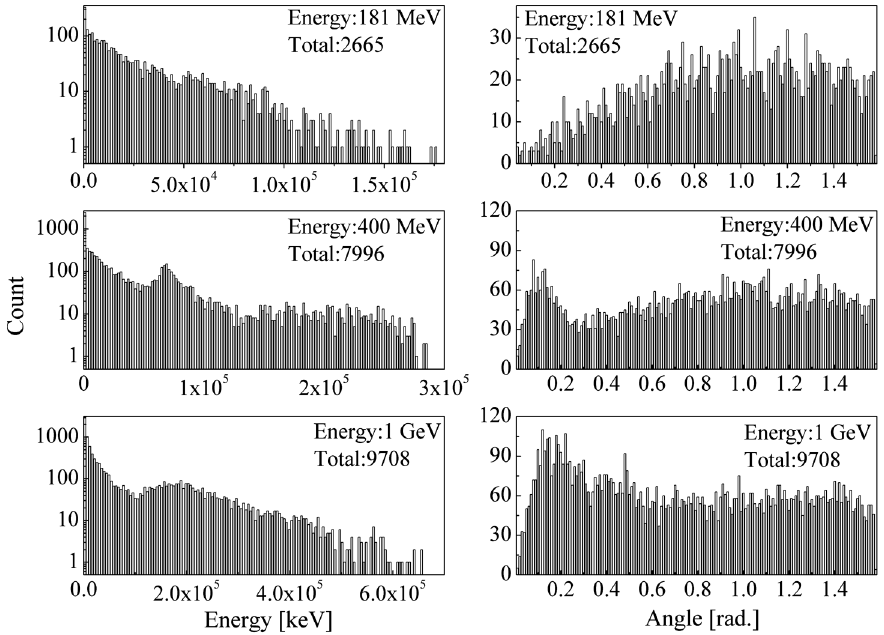
FIG. 2. Energy and angular spectra of the neutrons produced at the